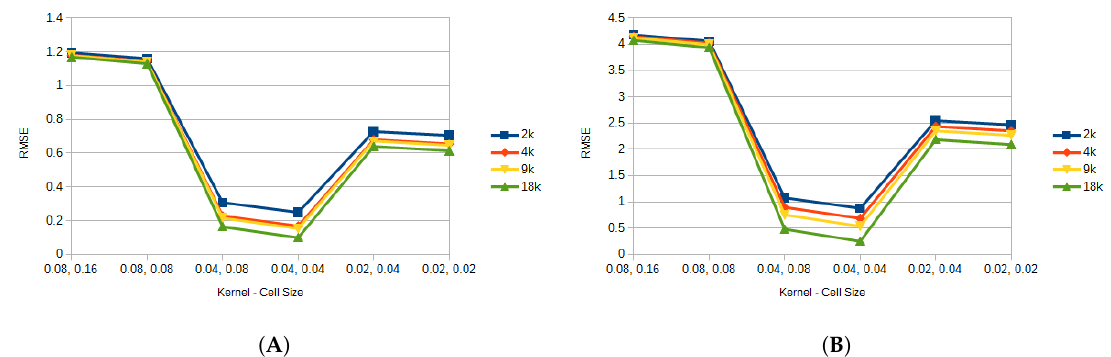
Figure 6. Average error for all the FEM resolutions for the triceps. ( A ) shows the average displacement error for all particle resolutions. ( B ) shows the average pressure error for all particle resolutions.